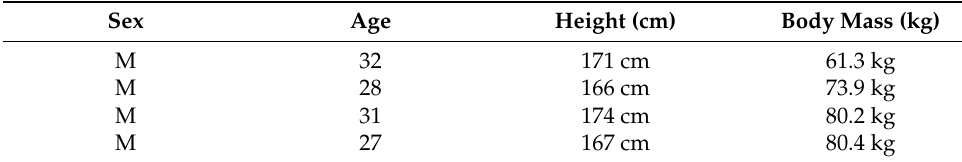
Table 3. Profiles of the